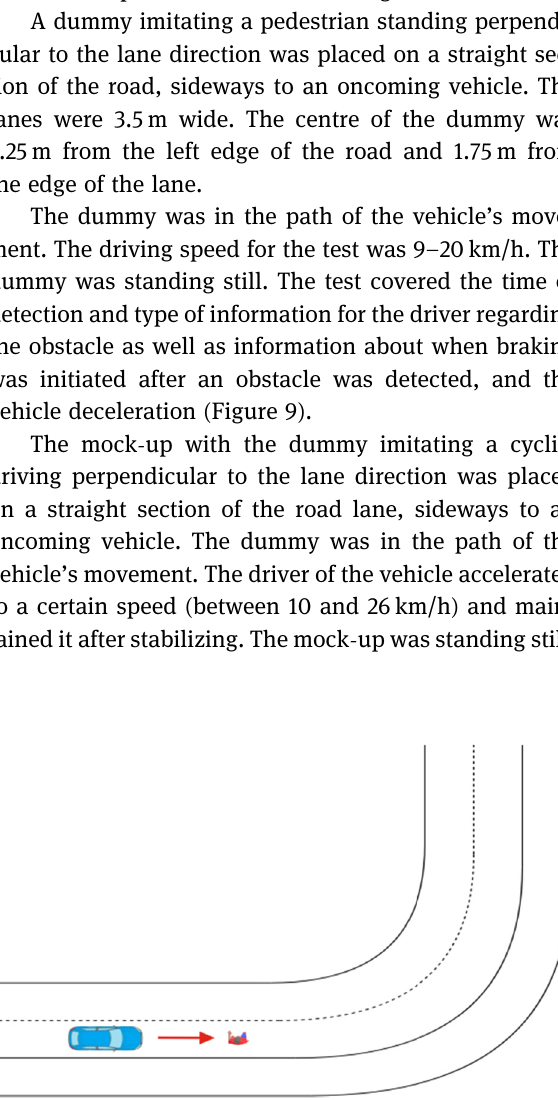
Figure 9: Research situation in test 1. Source: “ authors ” own research.